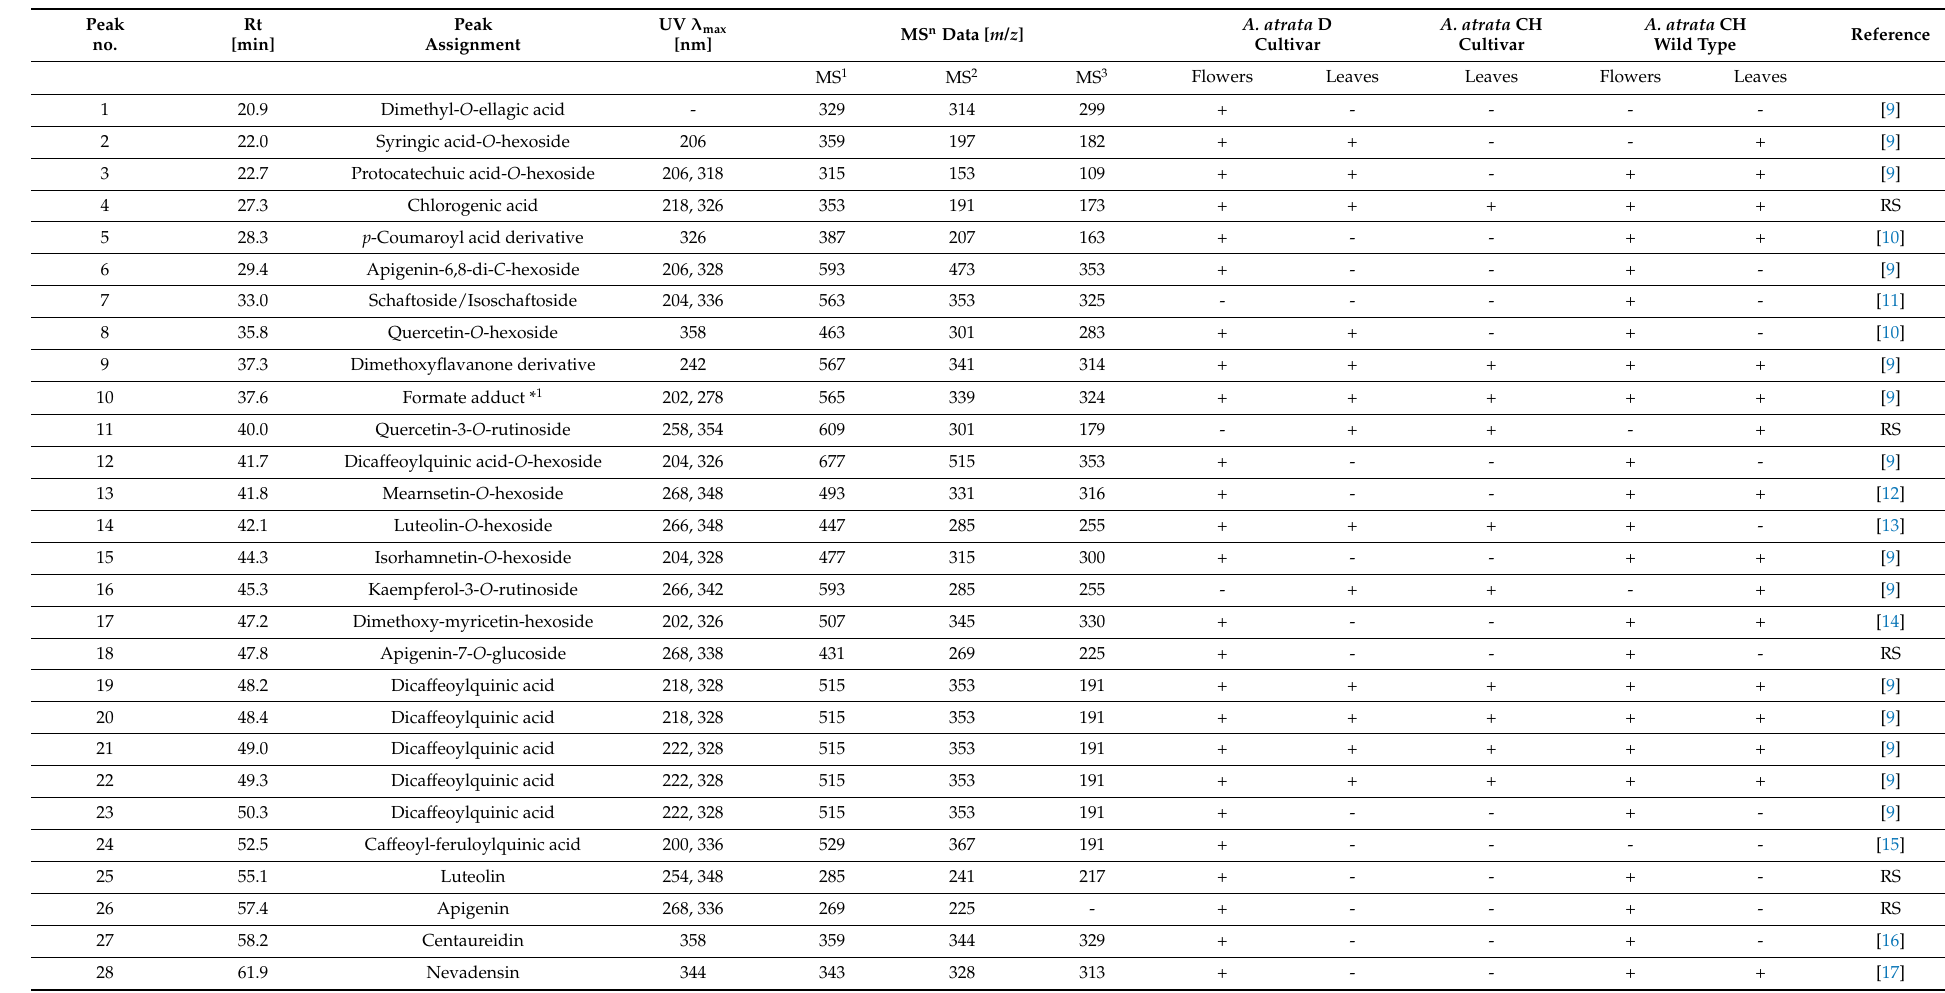
Table 1. Spectroscopic data (UV, MS) and HPLC retention times (R t ) of secondary metabolites of two A. atrata variants cultivated in Germany (D) and Switzerland (CH) and of the wild type (CH). For fragmentation experiments only the most intensive m / z ratios are given. Peak